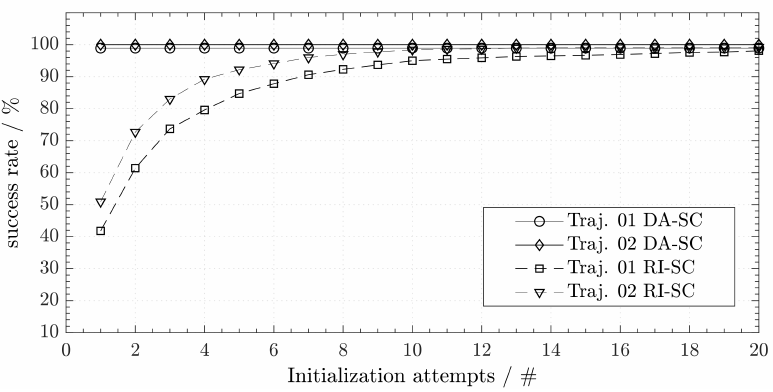
Figure 14. Comparison between the success rate of different initialization methods.